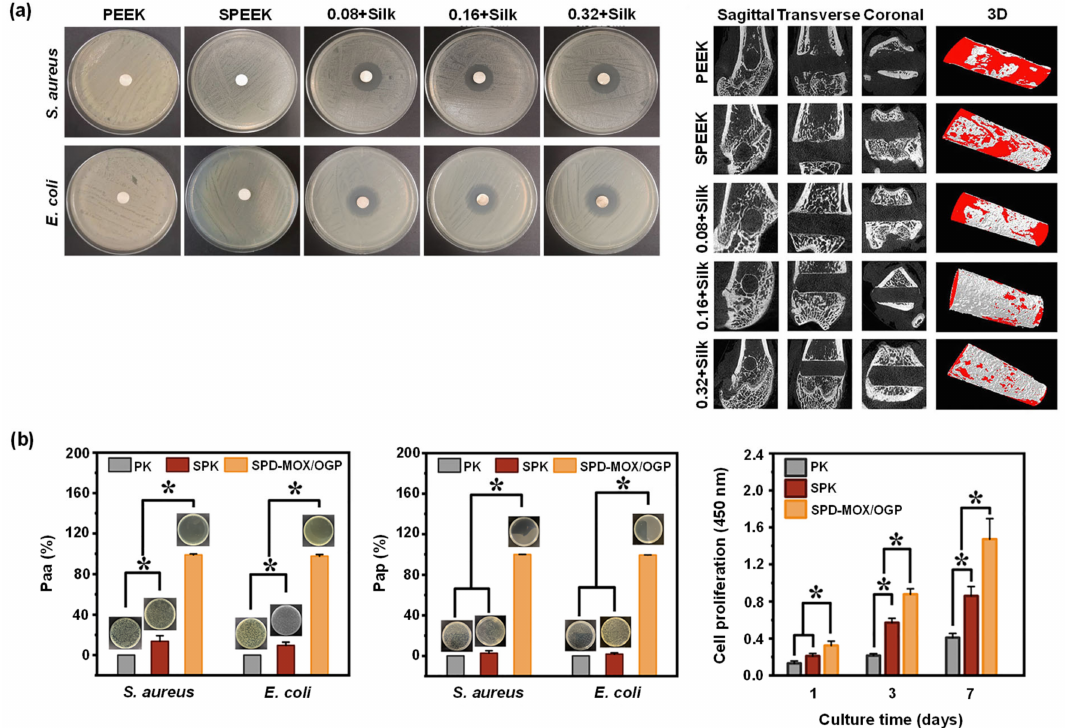
Figure 7. Sulfonation treatment of PEEK surface. ( a ) Sang et al. compared the biological properties of untreated PEEK (PEEK), sulfonated PEEK (SPEEK), and sulfonated PEEK coated with SrCO 3 - poly(dopamine) + gentamicin-silk protein ( n + silk, where n defines the concentration of SrCO 3 - poly(dopamine), i.e., 0.08 mg/mL, 0.16 mg/mL, and 0.32 mg/mL, respectively). Left: in vitro antibac- terial zone inhibition tests. Right: in vivo osteogenesis as imaged using µ CT [138]. ( b ) Biological prop- erties of untreated PEEK (PK), mildly sulfonated PEEK (SPK), and SPK layered with poly(dopamine) and loaded with moxifloxacin hydrochloride and growth peptide (SPD-MOX/OGP). Paa = an- tibacterial percentage of adherent bacteria. Pap = antibacterial percentage of planktonic